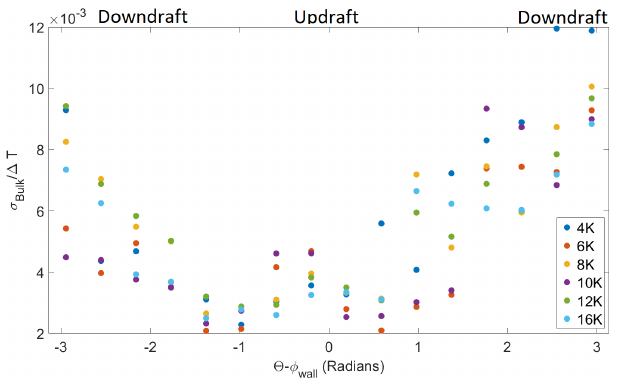
Figure 10. σ T normalized by (cid:49)T as a function of the angular dis- placement from the updraft. The temperature was filtered using a high-pass Fourier filter with the cutoff at around 5min.